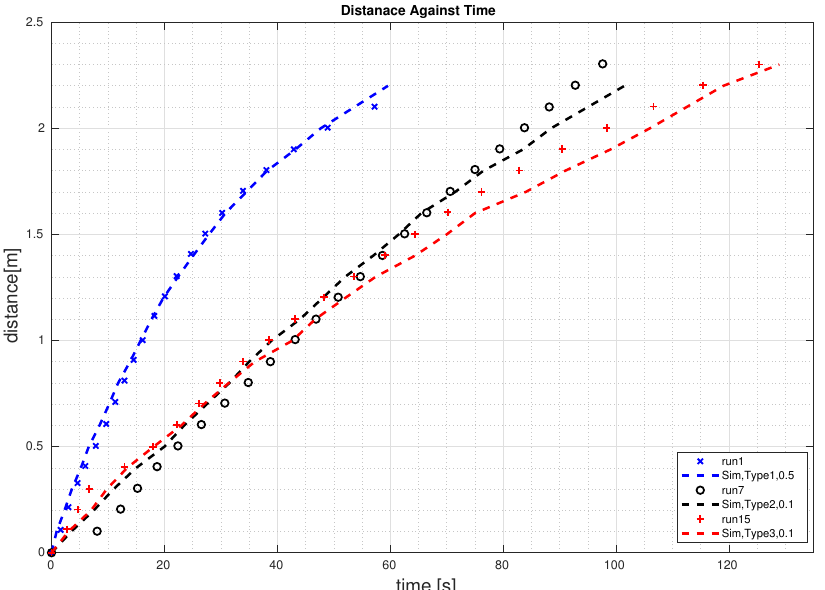
Figure 13. Validation cases for runs 1, 7 and 15. Front velocities of the numerical runs are compared to experimental